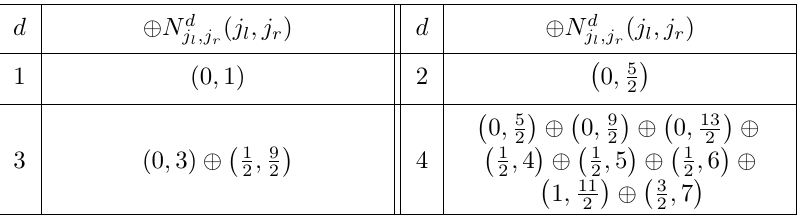
Table 13. BPS spectrum of a local P 2 for d ≤ 4 . Here, d labels the BPS states wrapping the degree d curve in P 2